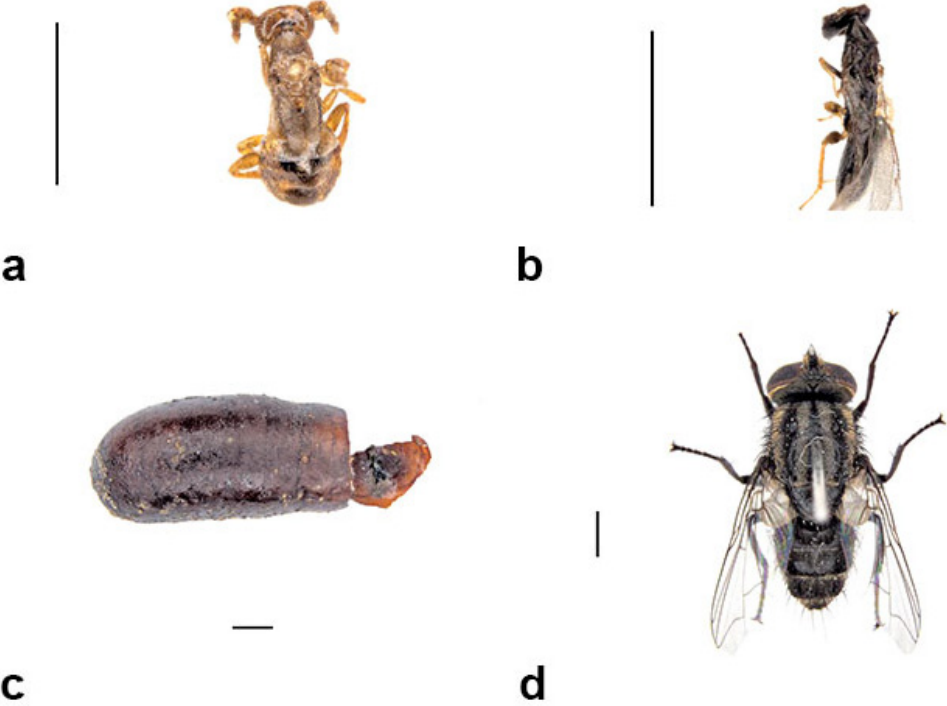
Figure 11. Main parasitoids of Sceliphron formosum , of which Melittobia australica was also seen parasitising other tenants: ( a ) dorsal view of male M. australica ( b ); dorsal view of female M. australica; ( c ) pupal case of Amobia burnsi; ( d ) dorsal view of A. burnsi . Scale bar = 1 mm.